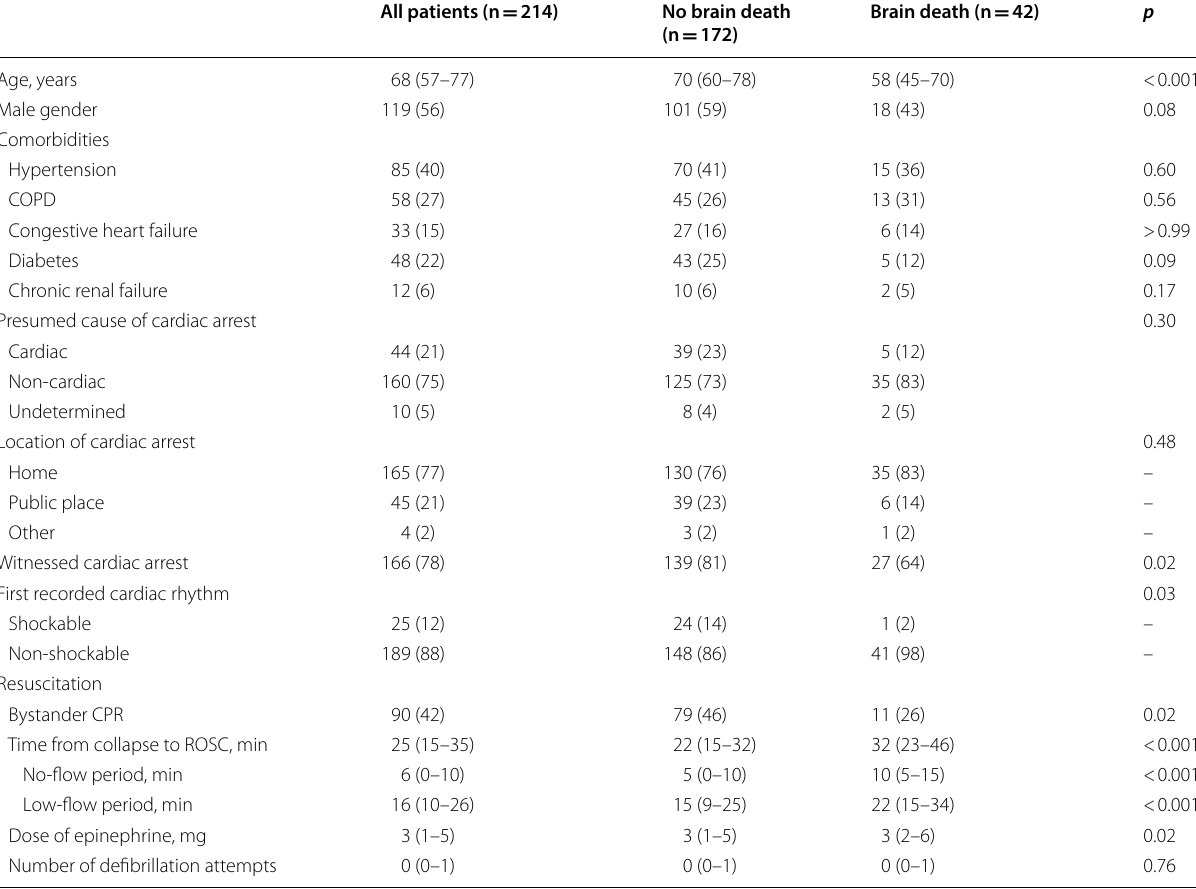
Table 1 Patient and cardiac arrest